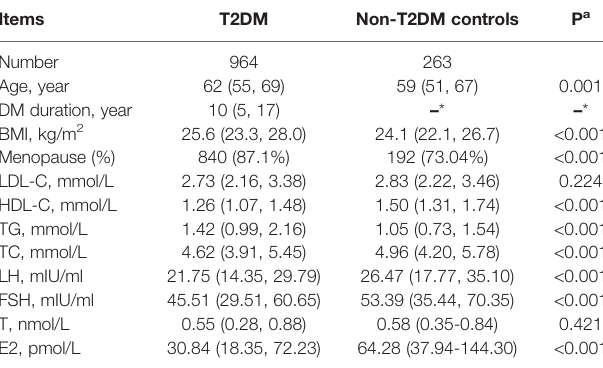
TABLE 1 | Summary of clinical features of patients with T2DM and non-T2DM controls. Items